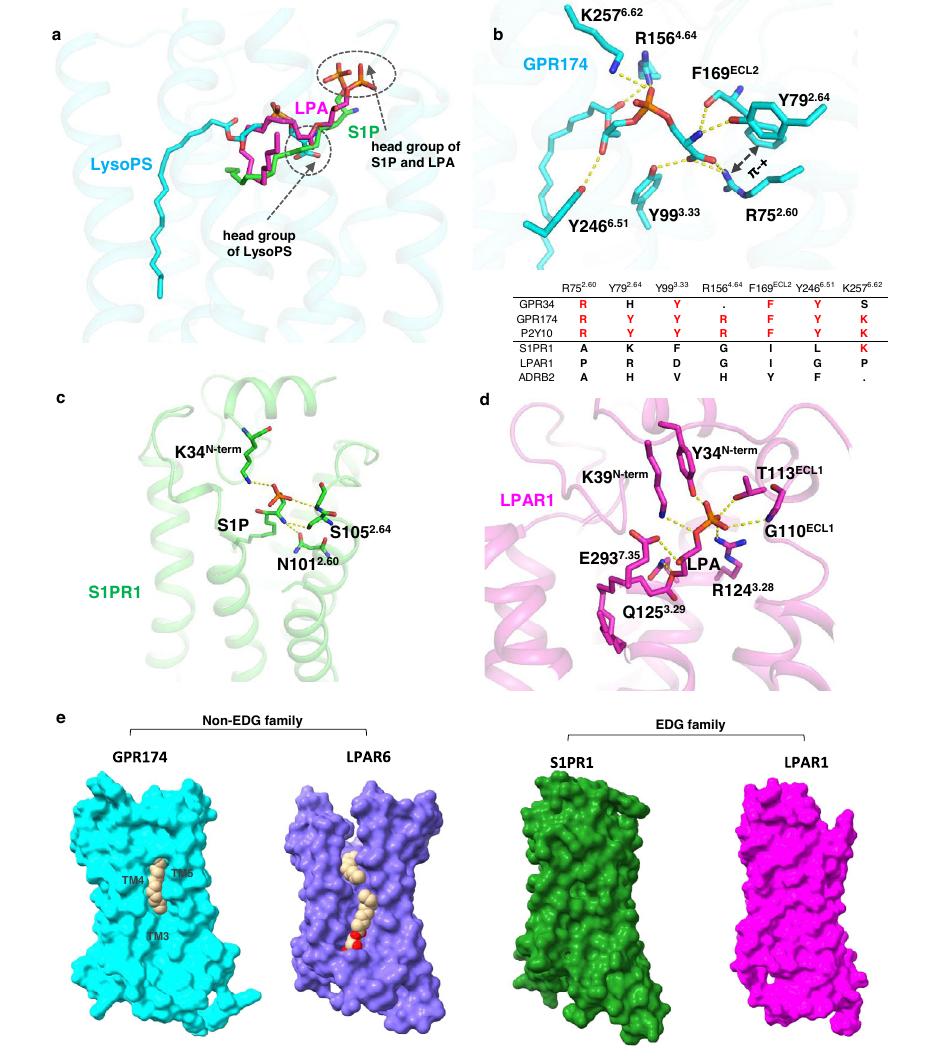
Fig. 3 | A comparison of receptor binding of LysoPS with LPA and S1P. a A superimposition of LysoPS with LPA (PDB:7td0) and S1P (PDB:7wf7) in GPR174. b The detail of polar interactions between LysoPS and the receptor in the ligand pocket. An alignment of key residues of the LysoPS family and S1PR1, LPAR1, and β 2AR in the lower panel, the red color marks the conserved residues of LysoPS